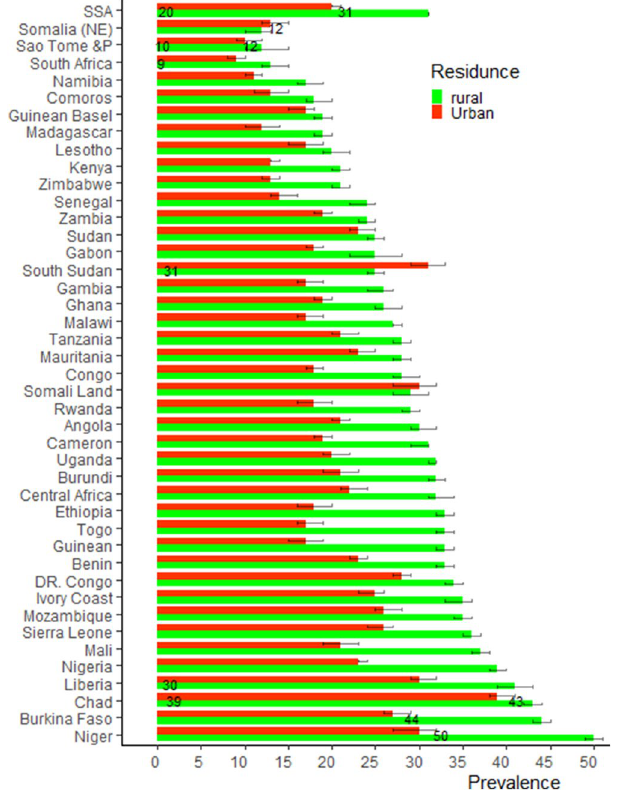
Figure 2. The proportion of women who suffer at least one child death by residence: the red and the green color indicate the proportion of urban and rural, respectively mothers who suffer in at least one child with confidence